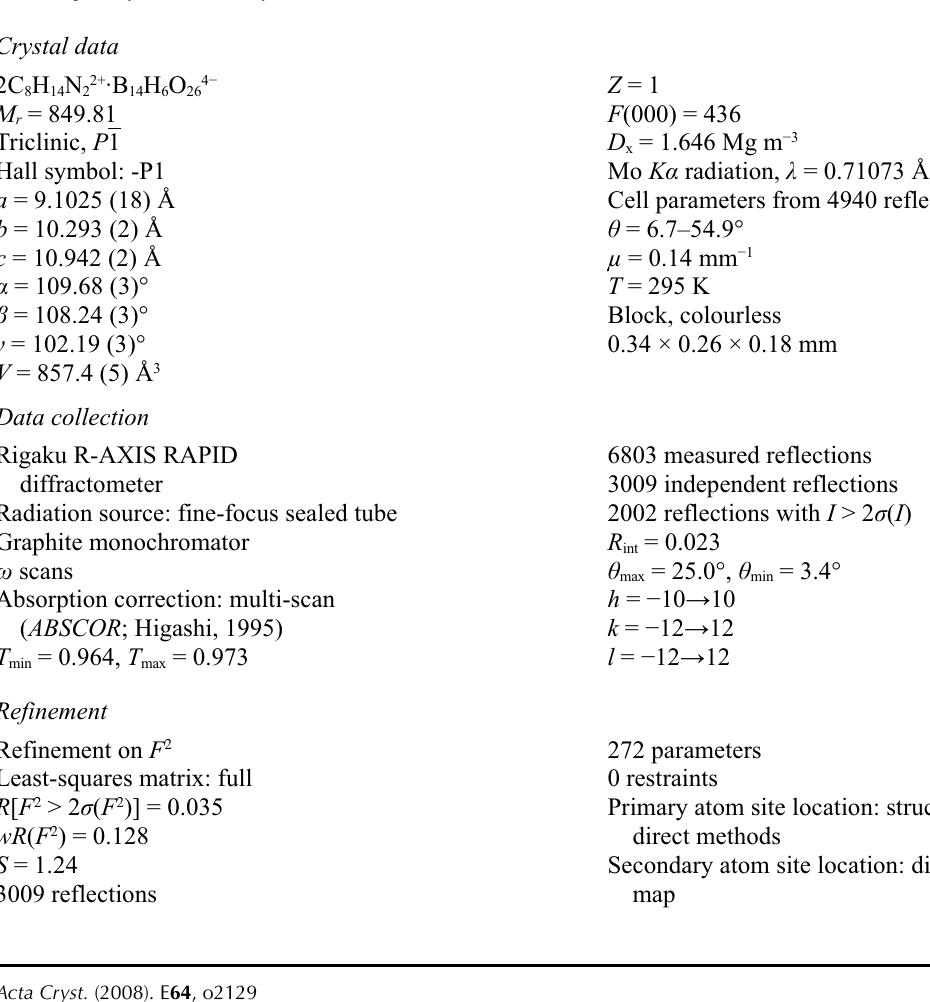
View of the diprotonated of organic amines in the inorganic borate network along a axis. Bis[(m-phenylenedimethylene)diammonium] tetradecaborate Crystal